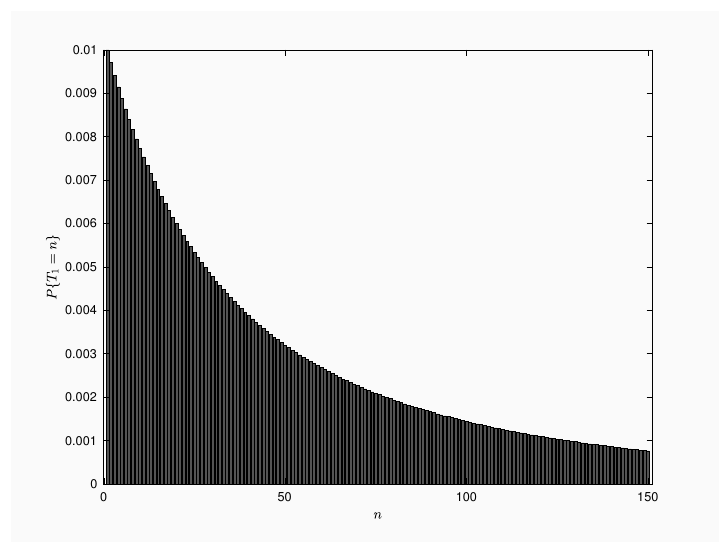
Figure 1. Mass function for N = 50.